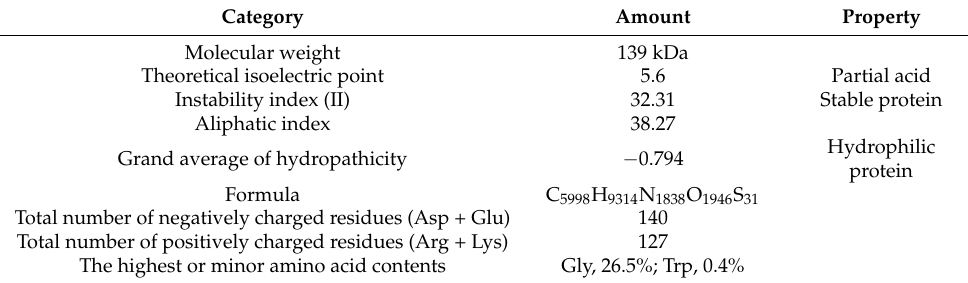
Table 4. Physicochemical properties of porcine